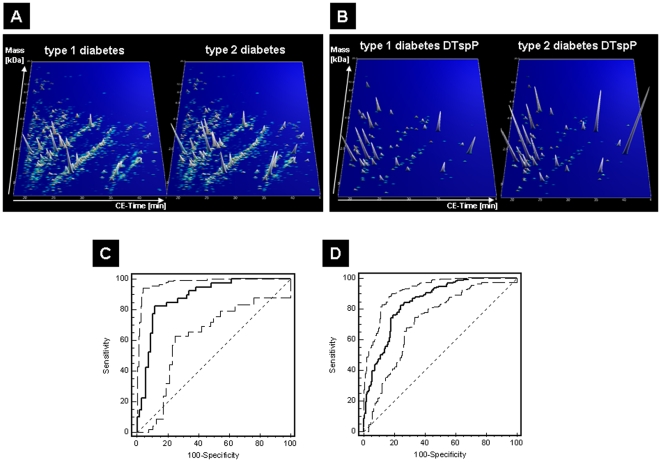
Development of diabetes type specific urinary biomarker pattern.(A) Compiled urinary protein profiles of patients with T1D (n = 68) and T2D (n = 42) included in the discovery set. Normalized molecular weight (800–20,000 Da) in logarithmic scale is plotted against normalized migration time (18–45 min). The mean signal intensity of polypeptides is given as peak height. (B) 3-D contour plots of the 131 DM type specific markers in the T1D and T2D patient cohort with 3x zoom compared to (A). ROC curves for differentiation of T1D and T2D in an independent validation set of T1D and T2D patients without clinical evidence of renal dysfunction (n = 108, AUC: 88%, C) and patients with evidence for renal dysfunction (n = 369, AUC: 85%, D).